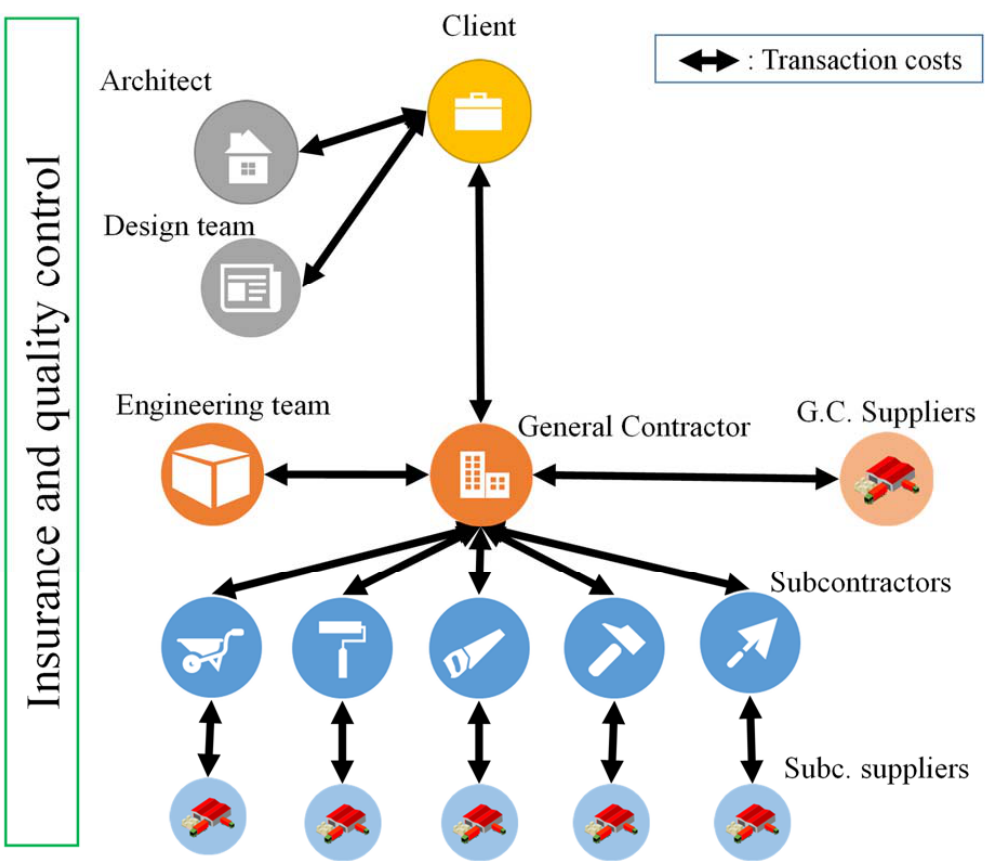
Buildings 2019 , 9 , 77 Figure 1. The contractual relationships and the flows of money Figure 1. The contractual relationships and the flows of money